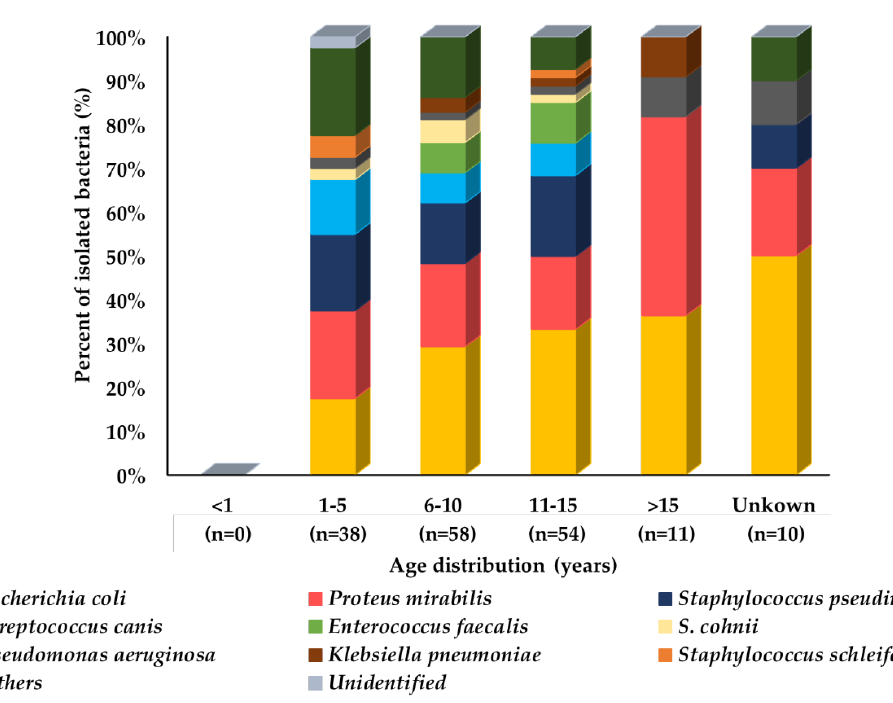
Figure 4. Prevalence of isolated bacteria (%) from dogs ’ urine specimens by age group (n = 171). In the graph, “ n ” represents the number of recovered isolates.